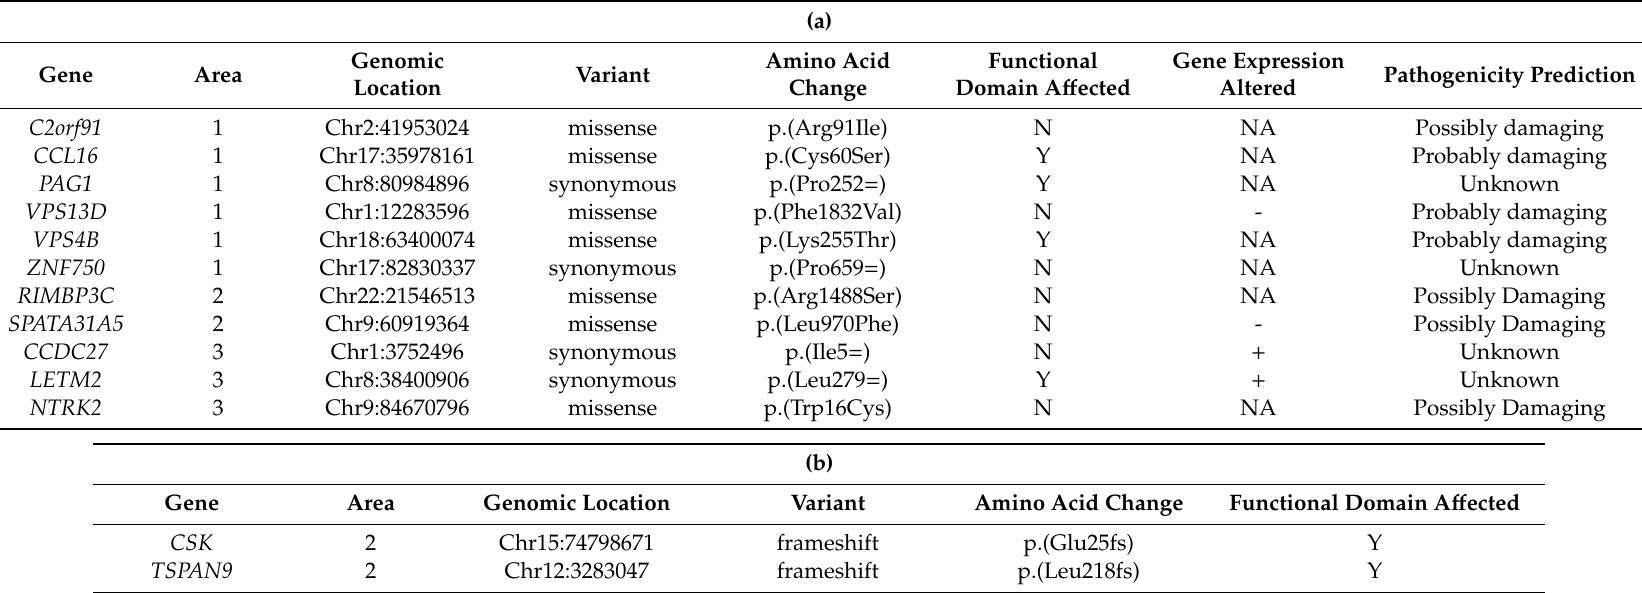
Table 3. (a) Details of the Tumor Related Somatic Variants in Coding Regions. Each gene with a somatic point variant is listed along with the area in which the variant occurred, the type of variant, the amino acid change, and whether or not the variant occurs in a putative functional domain. The final column lists whether or not the gene expression is altered in the area in which the variant occurred. The magnitude of gene expression is expressed as any of the following: NA indicates no change; “-” indicates 1-2 fold decrease in gene expression; “- -” indicates greater than 2 fold decrease in gene expression; “ + ” indicates 1-2 fold increase in gene expression; “ + + ” indicates greater than 2 fold increase in gene expression compared to two other areas. Pathogenicity predictions are made based on SIFT and PolyPhen scores. (b) Details of the Tumor Related Somatic Frameshift Variants in Coding Regions. Each gene with a somatic point variant resulting in a frameshift is listed along with the area in which the frameshift variant occurred and whether or not the frameshift variant occurs in a putative functional domain. (c) Details of the Tumor Related Somatic Variants in Non-coding Transcript Exons, Untranslated Regions, Introns, and Upstream and Downstream Genes. Each gene with a somatic point variant is listed along with the area in which the variant occurred, the genomic location, the type of variant, and whether or not the gene expression is altered in the area in which the variant occurred. The magnitude of gene expression is expressed as: NA indicates no change; “-“ indicates 1-2 fold decrease in gene expression; “- -” indicates greater than 2 fold decrease in gene expression; “ + ” indicates 1-2 fold increase in gene expression; “ + + ” indicates greater than 2 fold increase in gene expression compared to two other areas. The final column lists the potential impact rating as evaluated by VEP. All of these variants are listed as “modifier” indicating that predictions are di ffi cult or there is no evidence of